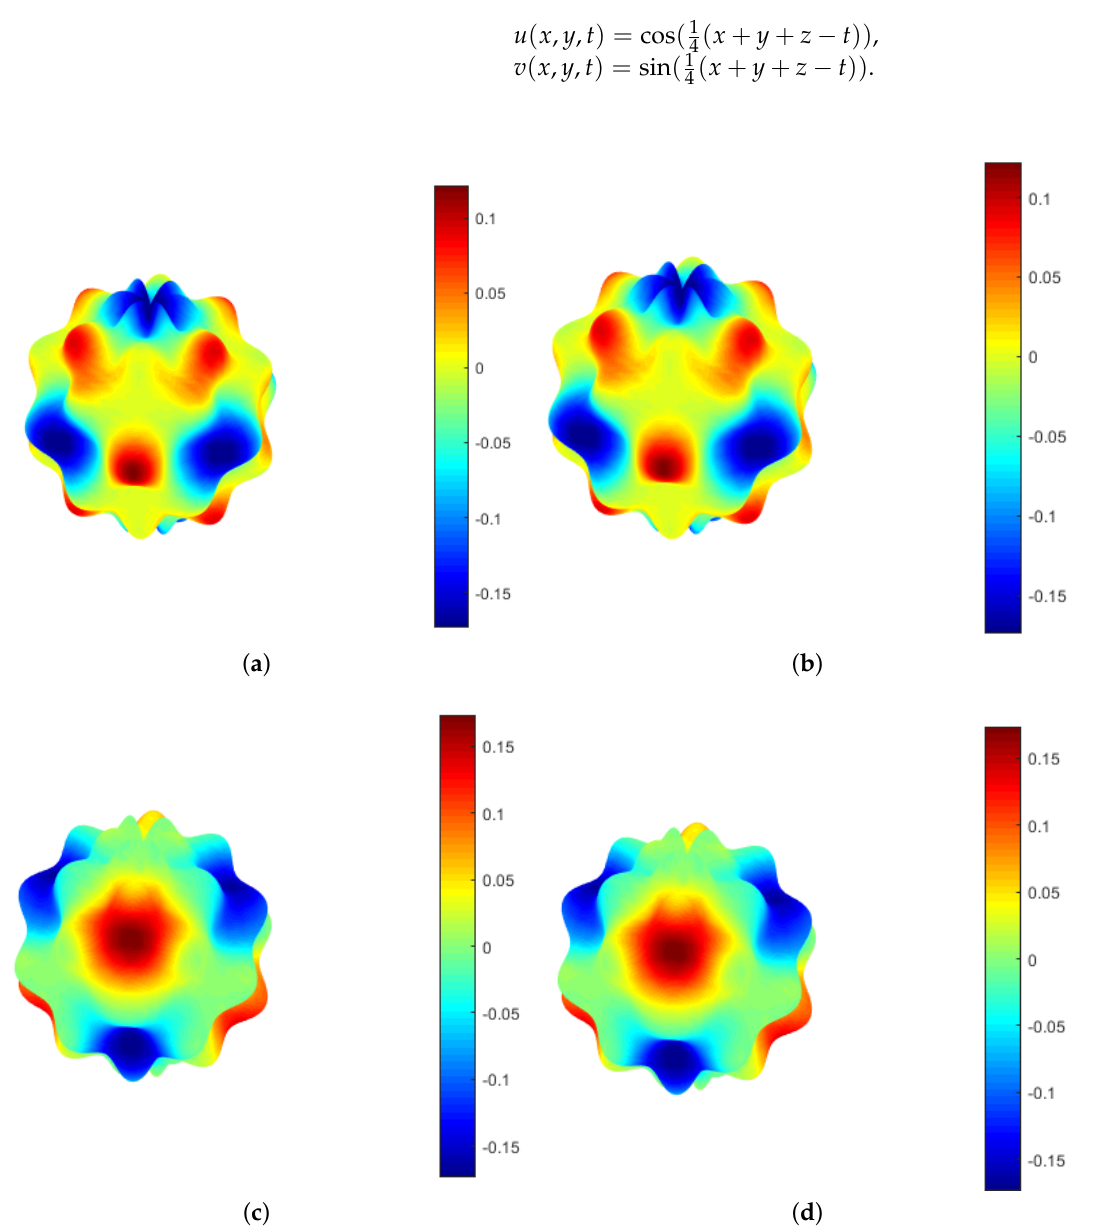
Figure 4. Plot of the exact solution ( a ) and plot of the approximate solution ( b ) related to u , and plot of the exact solution ( c ) and plot of the approximate solution ( d ) related to v with TPS for Example 2 by taking dx = 1